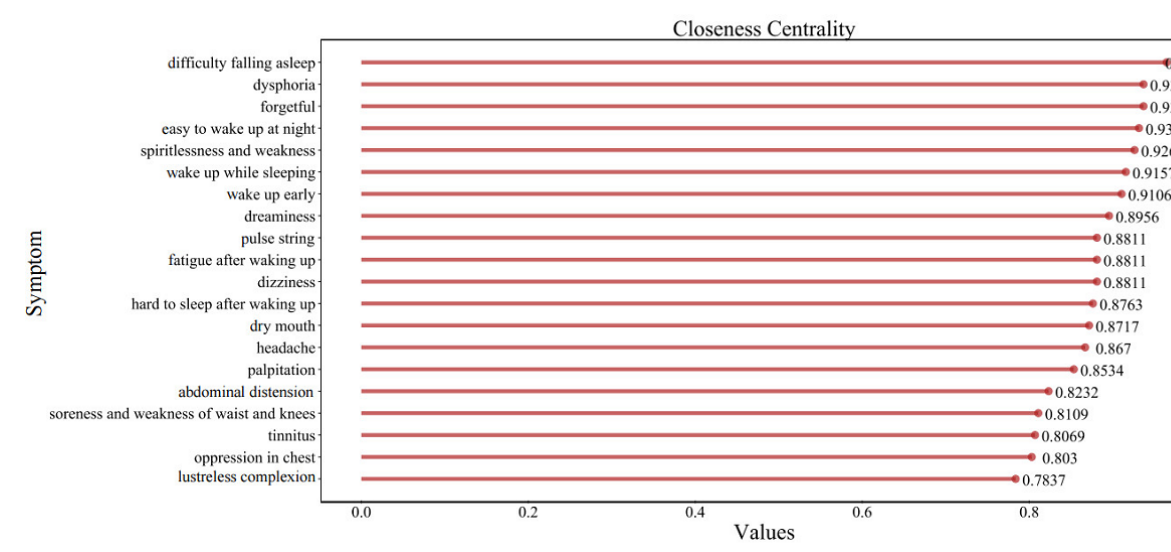
Figure 7. Closeness centrality of symptoms.